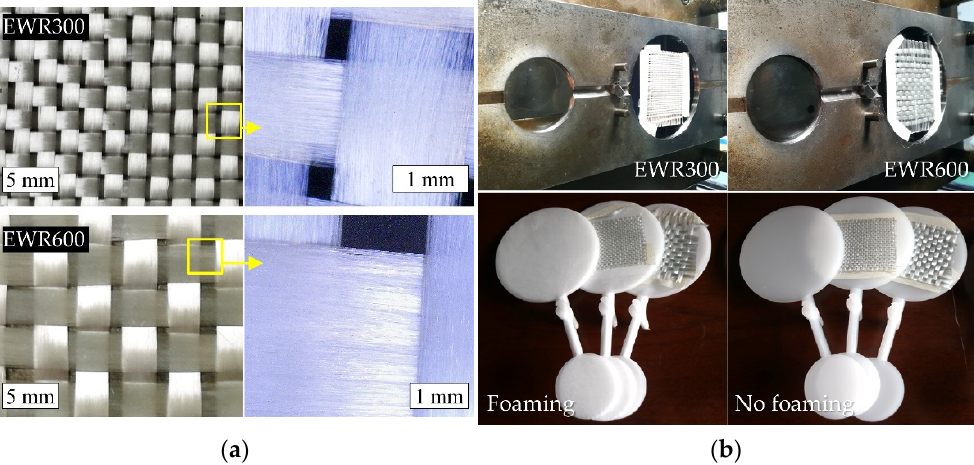
Figure 1. Photos of the glass fabrics ( a ), the mold cavity with inserted glass fiber fabrics and the prepared samples ( b ). Table 1. Material information of the glass fiber fabrics.